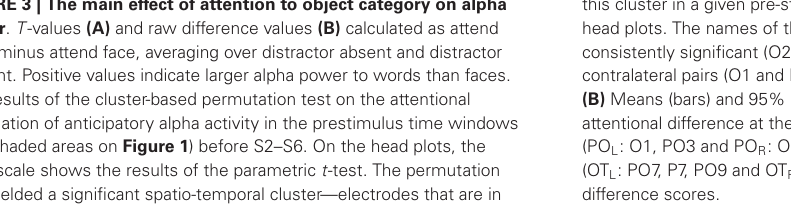
(77 ± 2%) conditions (main effect of category: F ( 1,15 ) =